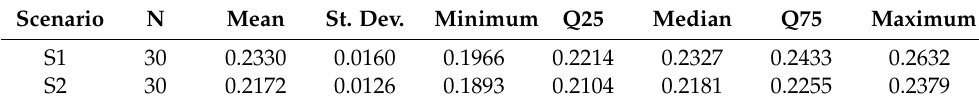
Table 2. Descriptive statistics of the average consumption per mile for both scenarios.